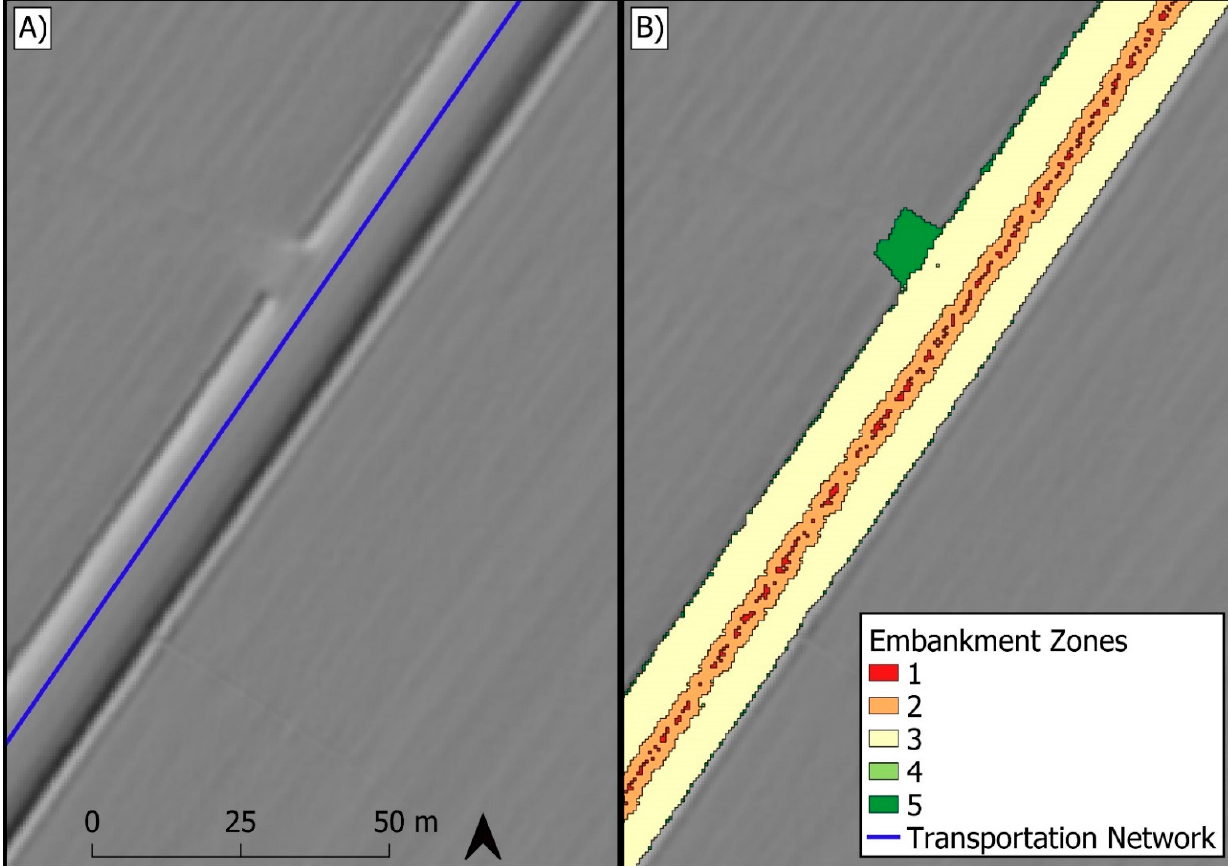
Figure 5. ( A ) A ditch-lined embankment; ( B ) The ditch-lined embankment identified by the algorithm. Notice the driveway that could potentially act as region spill-out point is mapped to Zone 5.